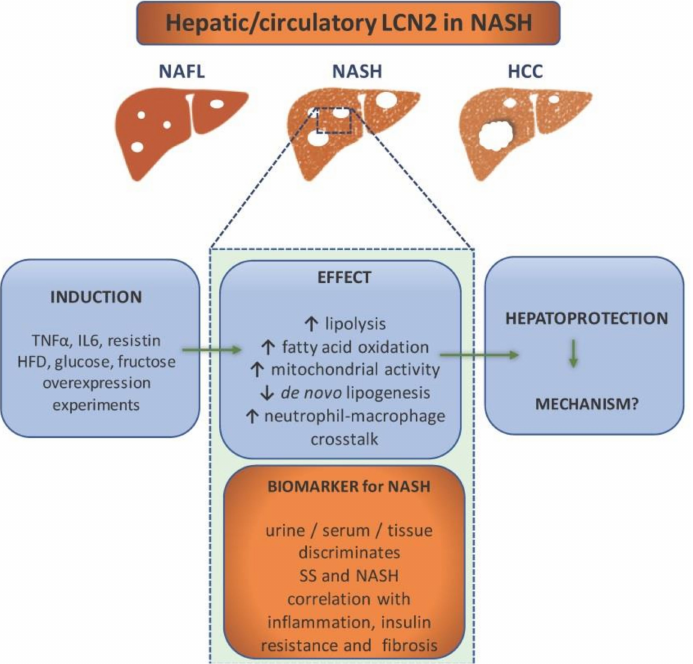
Figure 2. Lipocalin-2 (LCN2) as a component in non-alcoholic steatohepatitis (NASH) pathology and diagnostics. NASH patients show elevated levels of LCN2 in urine, serum, and liver tissue, which makes it a potential biomarker for NASH. It is able to discriminate between simple steatosis (SS) and NASH, while the level of LCN2 correlates with inflammation (e.g., increase of CRP), insulin resistance, and fibrosis. It is induced by proinflammatory cytokines, high fat diet, glucose, and fructose overconsumption. Overexpression experiments have implicated LCN2 in the enhancement of lipolysis, fatty acid oxidation, mitochondrial activity, and immune cells crosstalk. In addition, LCN2 upregulation is associated with reduced de novo lipogenesis. All evidence points out that its role is hepatoprotective. However, the exact mechanisms are ought to be